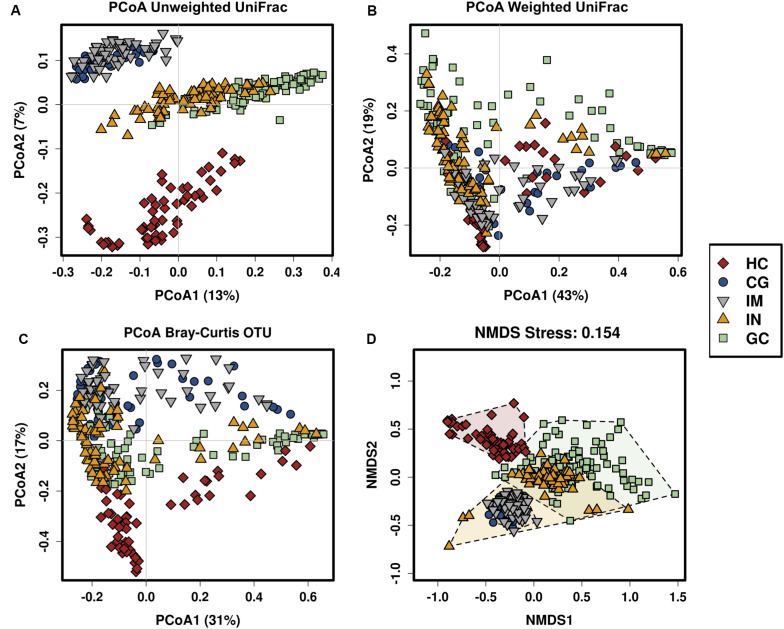
The gastric microbiota profile differs in HC and patients with CG, IM, IN, and GC. Principal coordinate analysis (PCoA) of (A) unweighted UniFrac distance matrix, (B) weighted UniFrac distance matrix, (C) Bray–Curtis distance matrix, and (D) non-metric multidimensional scaling (NMDS) based on the OTUs in which samples are colored and shaped by phenotype of the gastric mucosa.